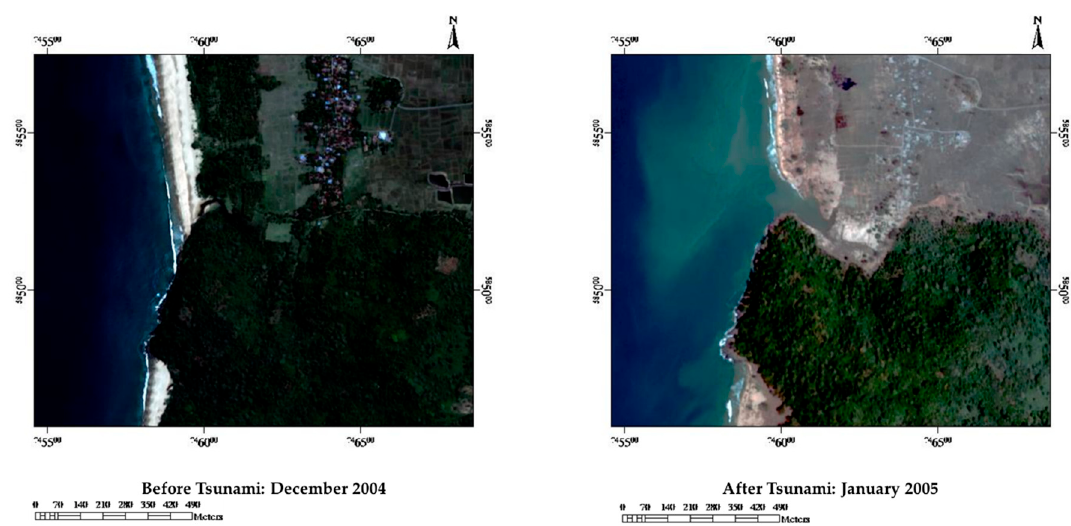
Figure 7. True-color composite of satellite images acquired from Quickbird imagery over Indonesia.